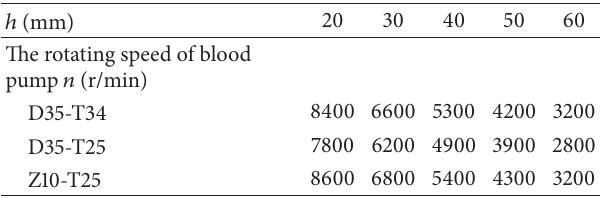
Figure 12 indicates the